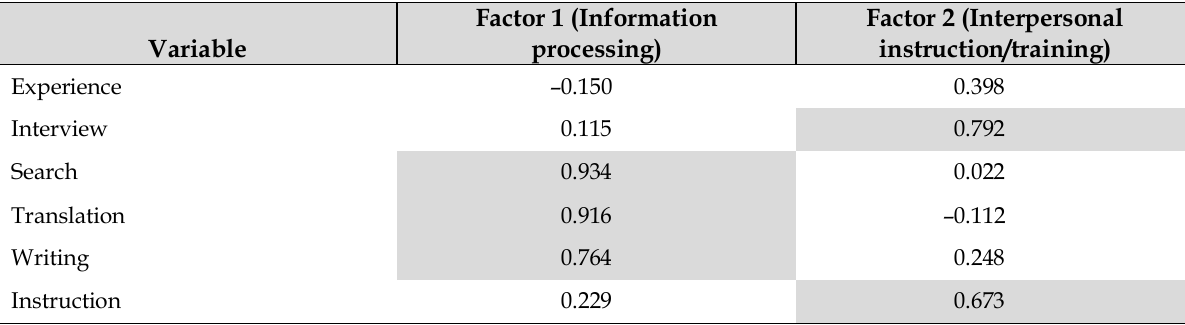
Table 5 Factor structure after VARIMAX rotation Variable